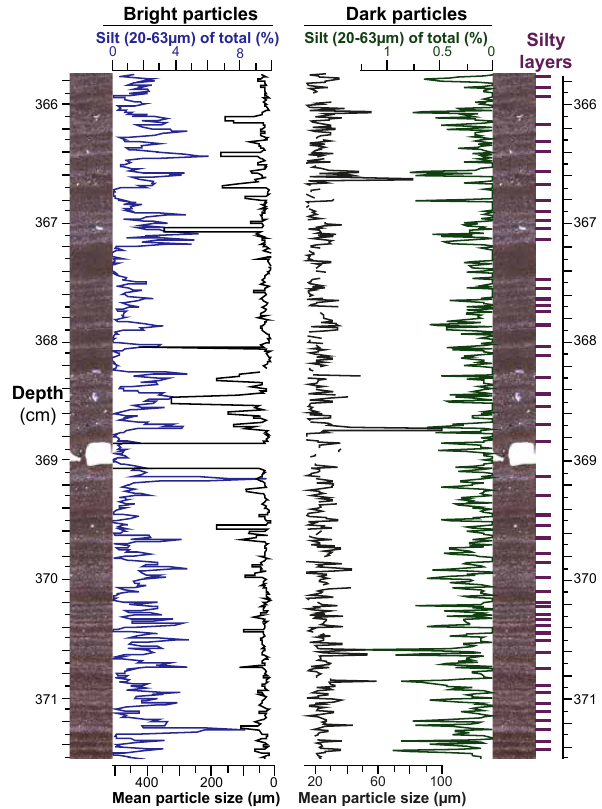
Fig. 6. Detailed particle analysis of the varved sediment section 365.8 – 371.5 cm with the 2 Figure 6. Detailed particle analysis of the varved sediment section RADIUS tool (Seelos and Sirocko, 2005) applied on high-resolution scans of the thin 3 365.8–371.5cm with the RADIUS tool (Seelos and Sirocko, 2005) sections. The 20-63 µ m fraction refers to medium to coarse silt. Total refers to all analysed 4 applied on high-resolution scans of the thin sections. The 20–63µm particle classes from 20 to 200 µ m in grain size. Purple bars mark the 52 counted lighter 5 fraction refers to medium to coarse silt. Total refers to all analysed particle classes from 20 to 200µm in grain size. Purple bars mark coarser-grained layers leading to a linear sedimentation rate of about 1.1 m/kyr. 6 the 52 counted lighter coarser-grained layers leading to a linear sed- imentation rate of about 1.1mkyr − 1